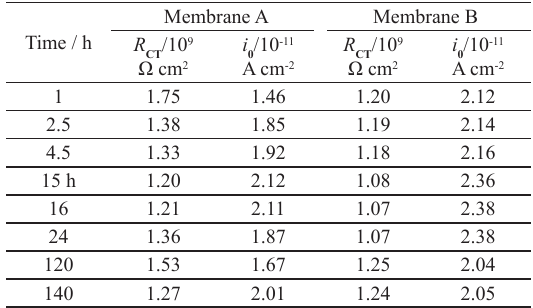
Table 2. Charge transfer resistances ( R current density ( i /A cm -2 ) for membranes A and B 0